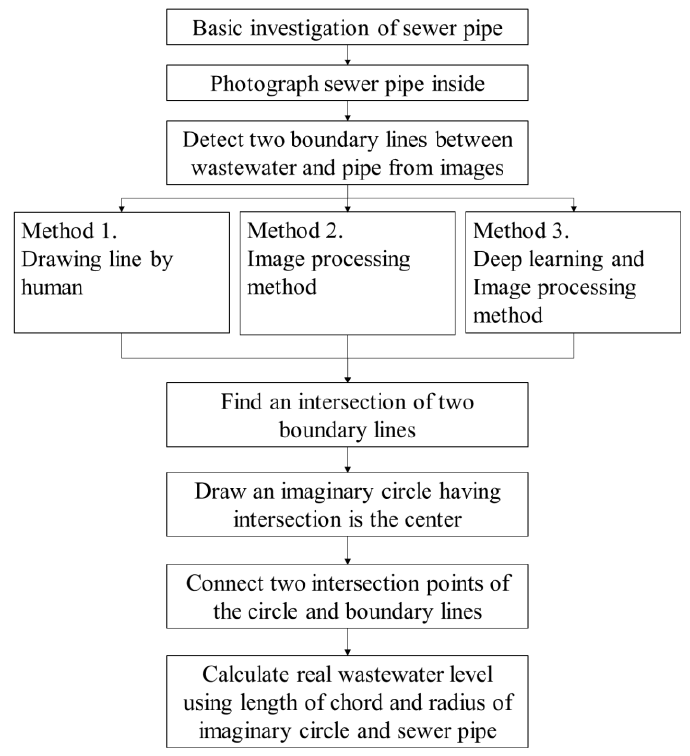
Figure 1. Procedure to calculate wastewater level from images.